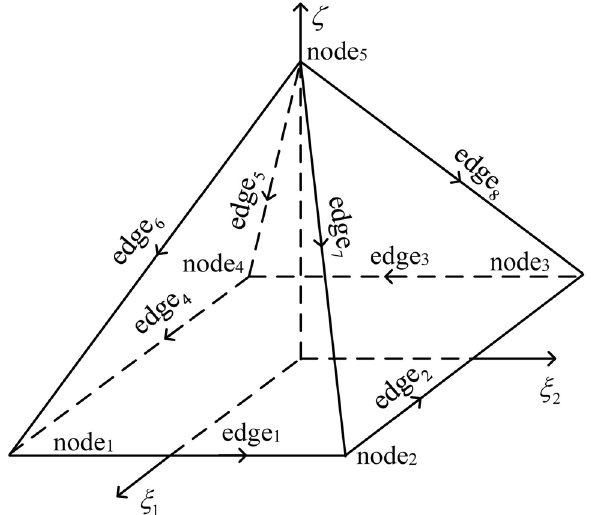
Figure 3. Illustration of one pyramid element. There are five nodes and eight edges in the element, and the serial numbers of nodes and edges are defined in the coordinate system ( ξ 1 , ξ 2 , ξ